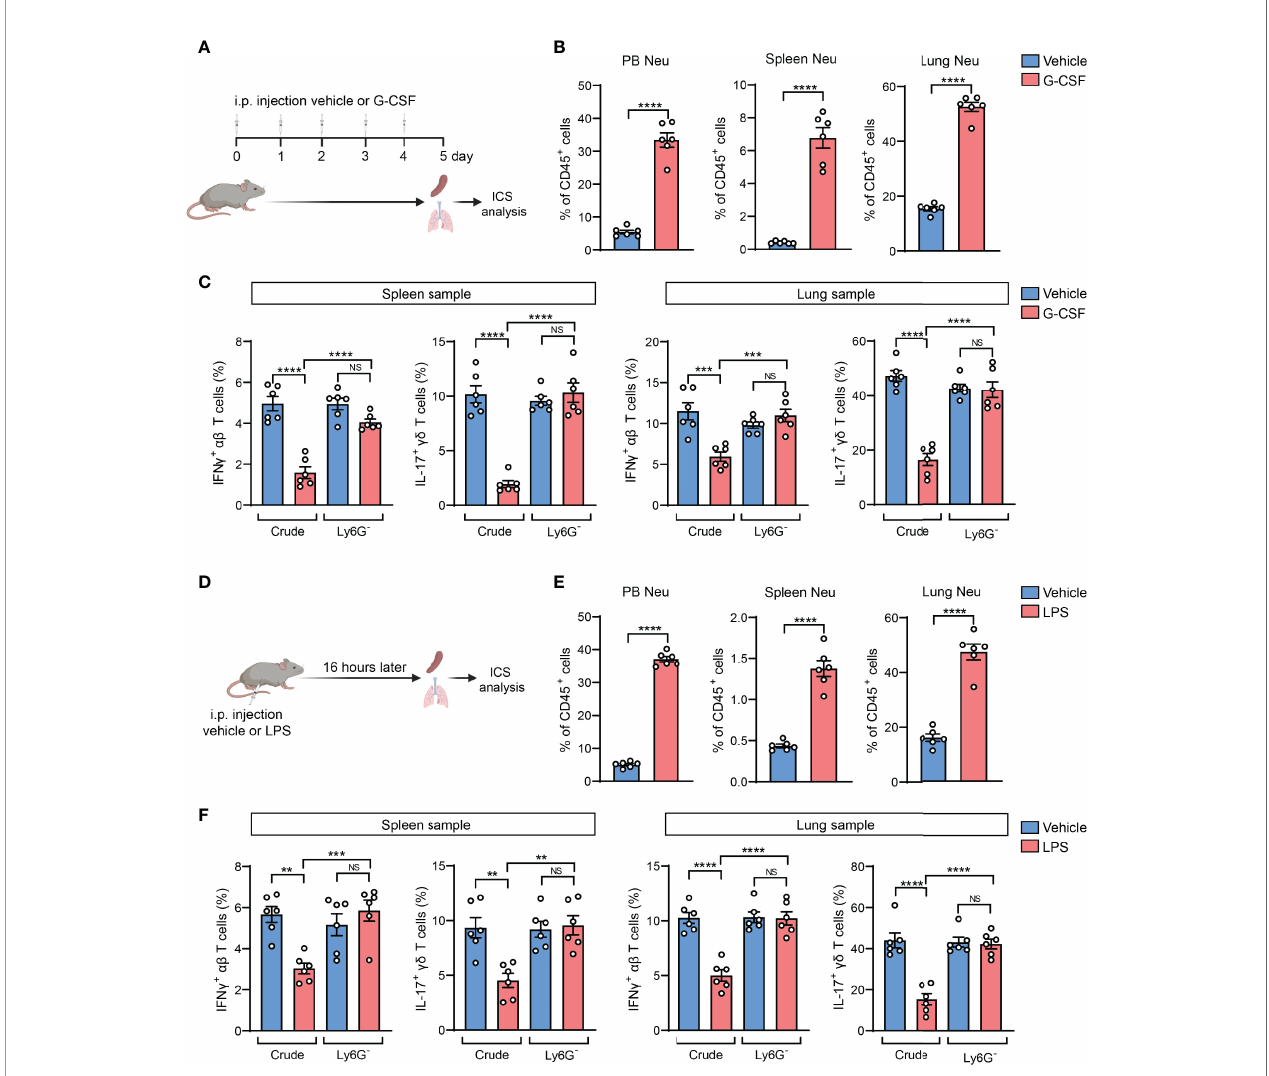
FIGURE 4 | The neutrophil-induced artifact occurs in other host neutrophilia conditions than tumor models. (A – C) , As depicted in (A) the mice were received i.p. injection of recombinant mouse G-CSF (0.125 mg/kg) or vehicle for 5 consecutive days. The percentages of neutrophils (CD45 + CD11b + Ly6G + ) in peripheral blood (PB), spleen or lungs were quanti fi ed (B) . The frequencies of IFN g + ab T cells or IL-17 + gd T cells in spleen or lung samples (n=6 per group) with or without neutrophil depletion, were detected ICS and fl ow cytometry (C) . (D – F) , As depicted in (D) the mice were received i.p. injection of LPS (2.5 mg/kg) or vehicle. 16 hours later, the percentages of neutrophils in PB, spleen or lung were quanti fi ed (E) . The frequencies of IFN g + ab T cells or IL-17 + gd T cells in spleen or lung samples (n=6 per group) with or without neutrophil depletion, were detected by ICS and fl ow cytometry (F) . Values of n represent biologically independent animals. Data are mean ± s.e.m. P values were calculated using unpaired t -test (B , E) or one-way ANOVA (C , F) . ** P < 0.01; *** P < 0.001; **** P < 0.0001. NS, not signi fi